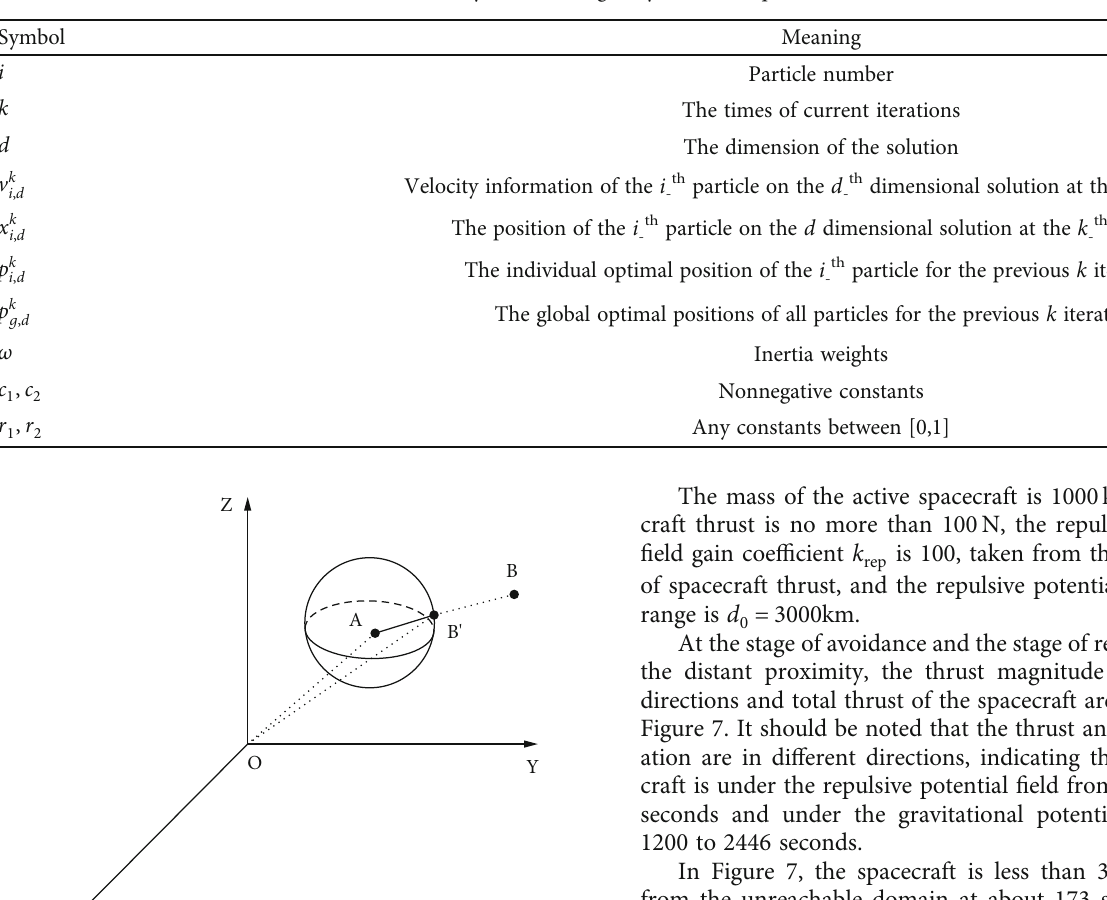
Table 1: Physical meaning of symbols in Equation (46).